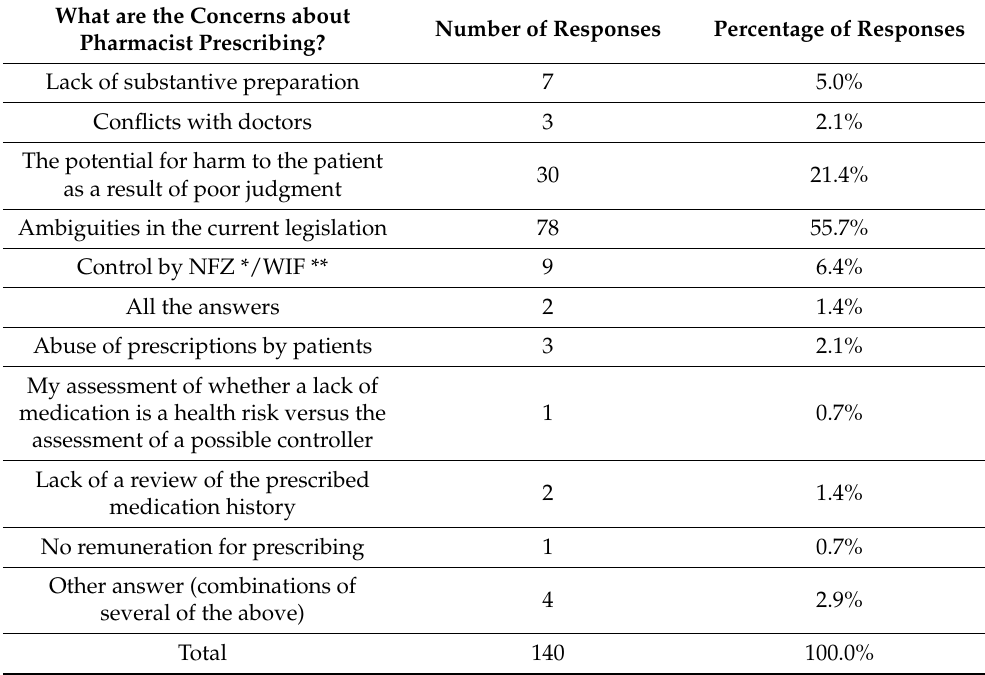
Table 4. Distribution of responses to the question about what the perceived concerns about prescrib- ing